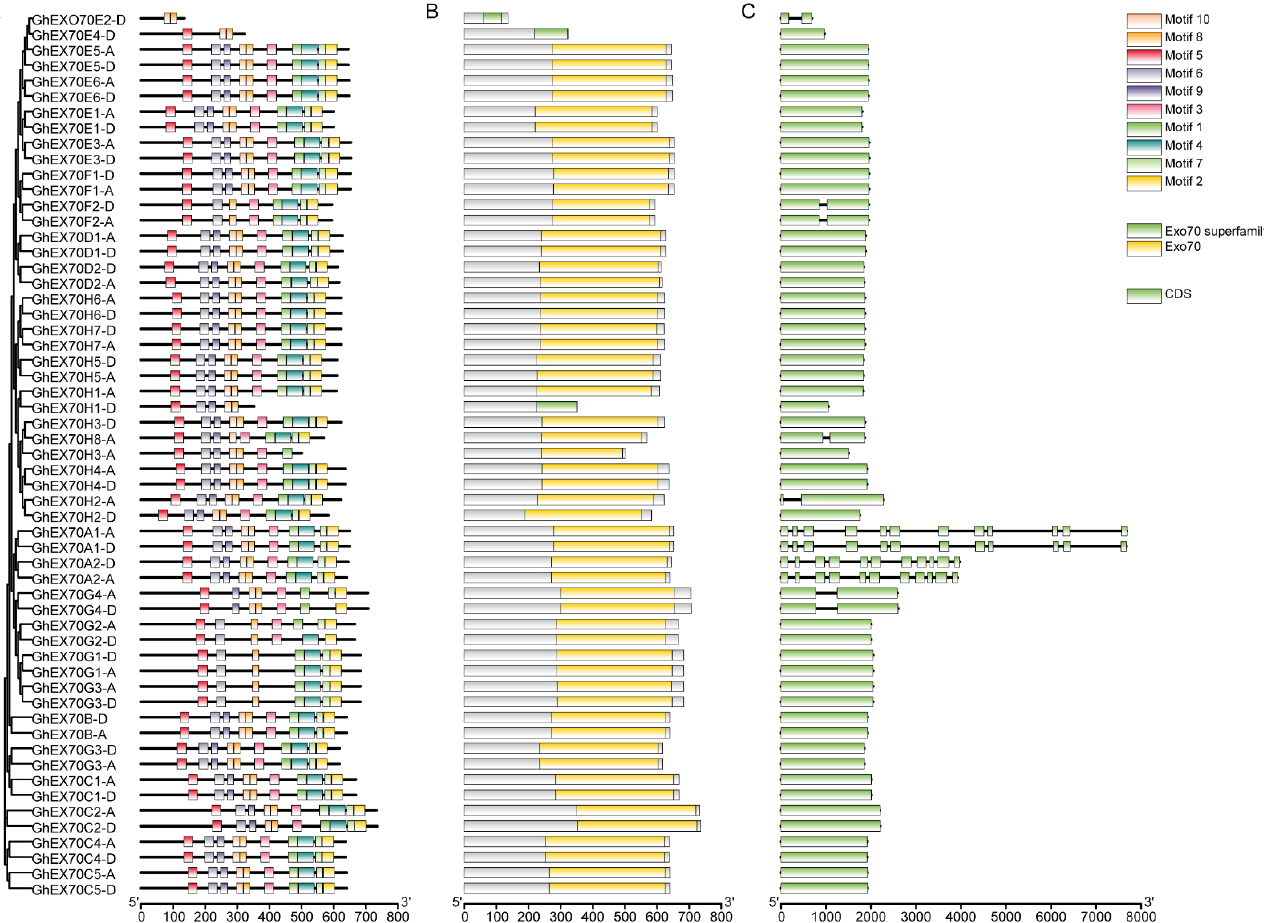
Figure 3. EXO70 family motif, domain, and gene structure in upland cotton. ( A ) Phylogenetic tree and motif of GhEXO70 proteins. ( B ) The conserved domains in GhEXO70 proteins. ( C ) Gene structure of the GhEXO70 family.